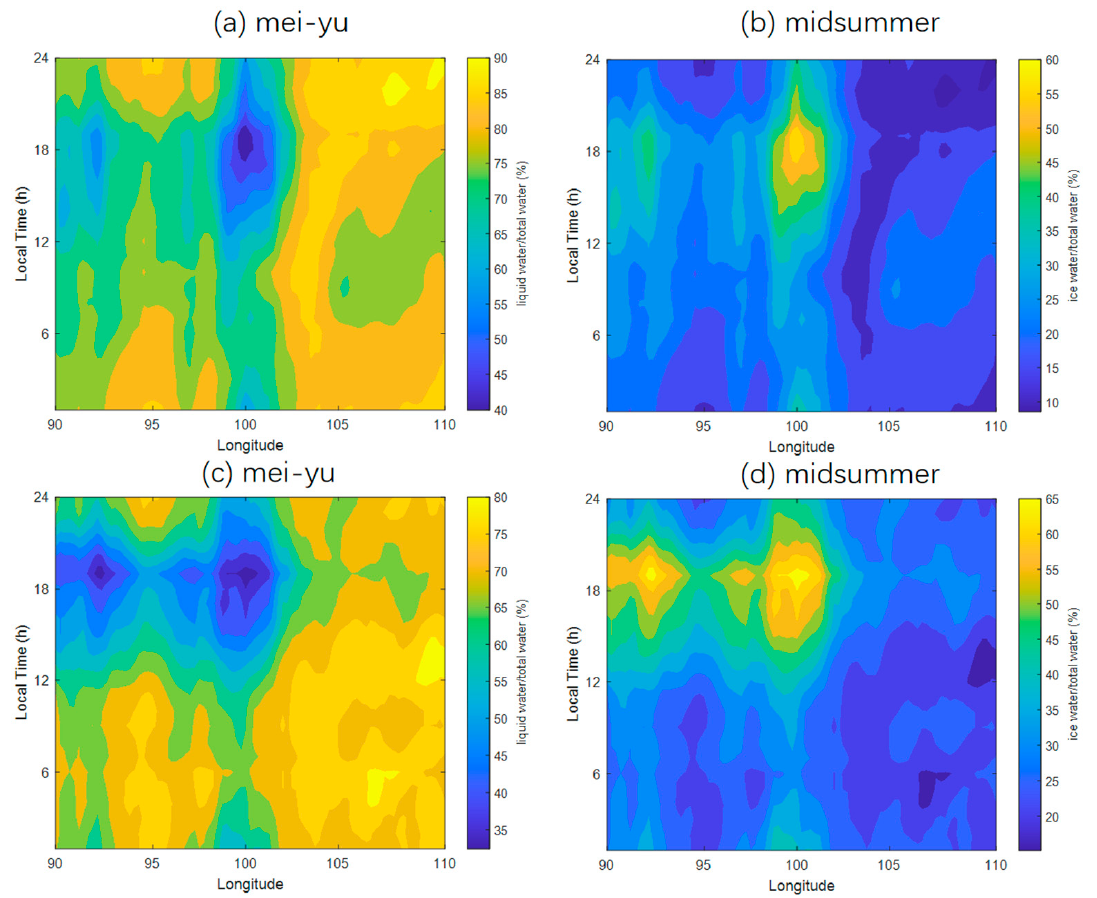
Figure 4. Ratio of cloud ( a , c ) liquid water and ( b , d ) ice water to total cloud water during the ( a , b ) mei-yu and ( c , d ) midsummer periods.